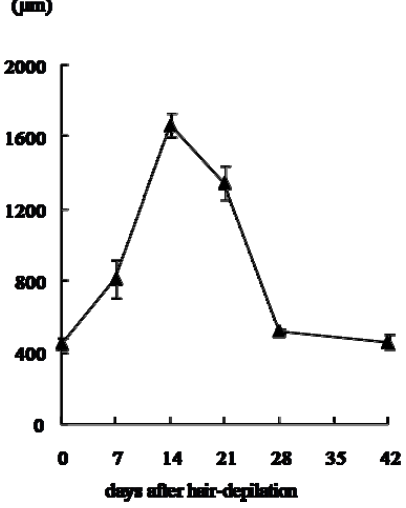
Figure 2. Changes in depth (length) of hair follicles in dorsal skin of male Mini rats after depilation of telogen-phase hairs at 10 weeks of age. The data represents mean + standard deviation of three animals except for the group at 42 days after depilation (two